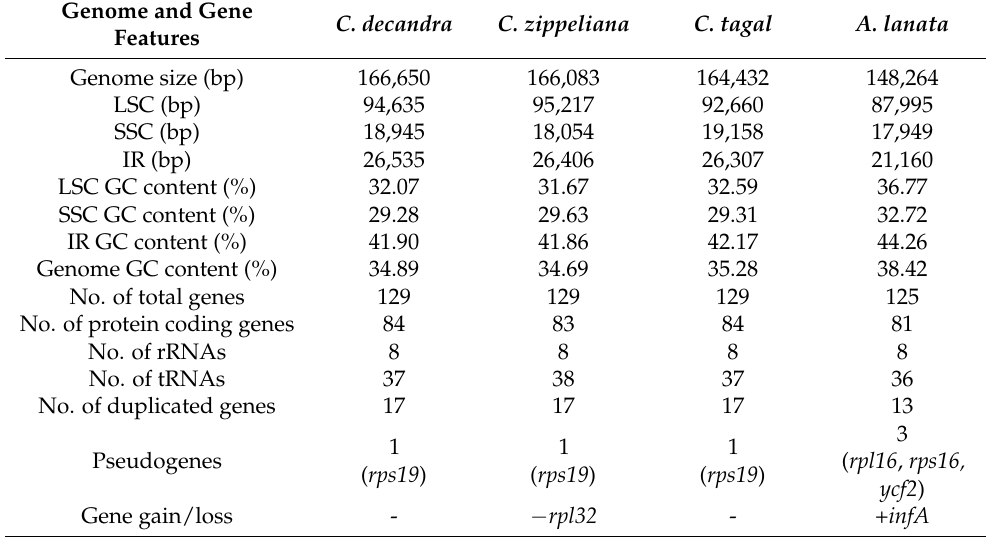
Table 1. Summary of the chloroplast genomes of three Ceriops species and Avicennia lanata . Genome and Gene Features